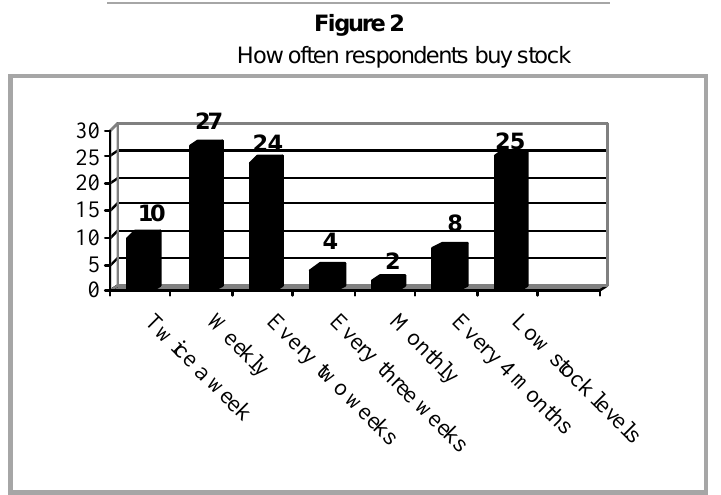
How often respondents buy